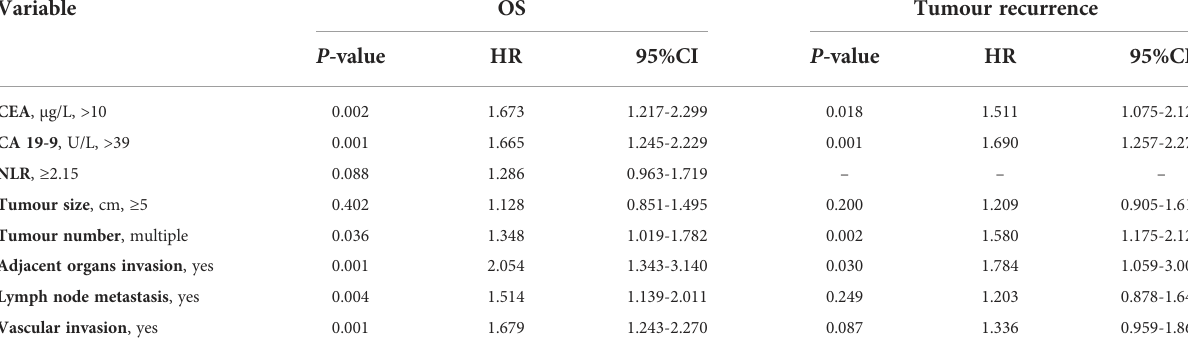
TABLE 4 Multivariate analysis of prognostic factors in ICC patients with no HBV infection. Variable